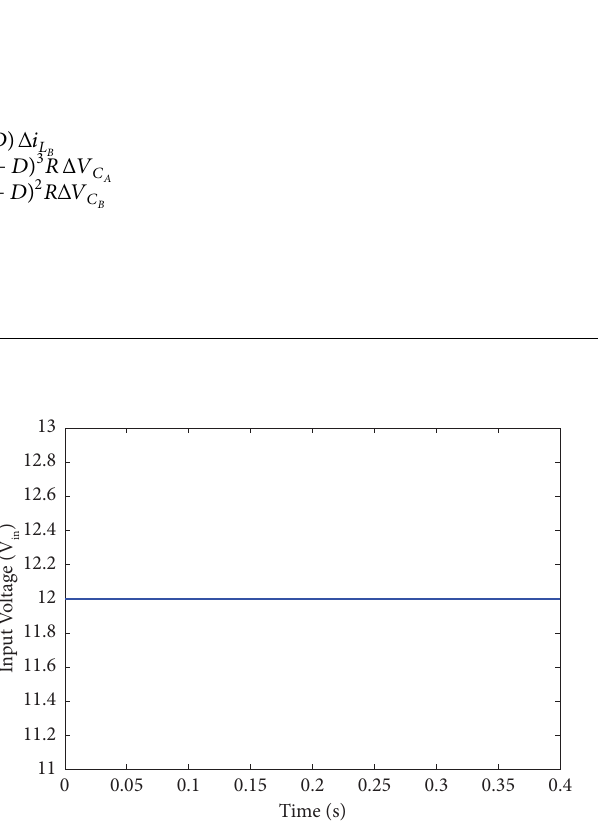
Figure 5: MATLAB simulated input voltage 12V ( V ) waveform of the proposed in displayed in Figure 6. Te simulated waveform of the input Figure 5 depicts a simulated waveform of input voltage current does not hit the zero level, as discussed in the (12 V) obtained from a DC voltage source. Te simulated theoretical analysis. As a result, the proposed converter input current waveforms for the few switching cycles are